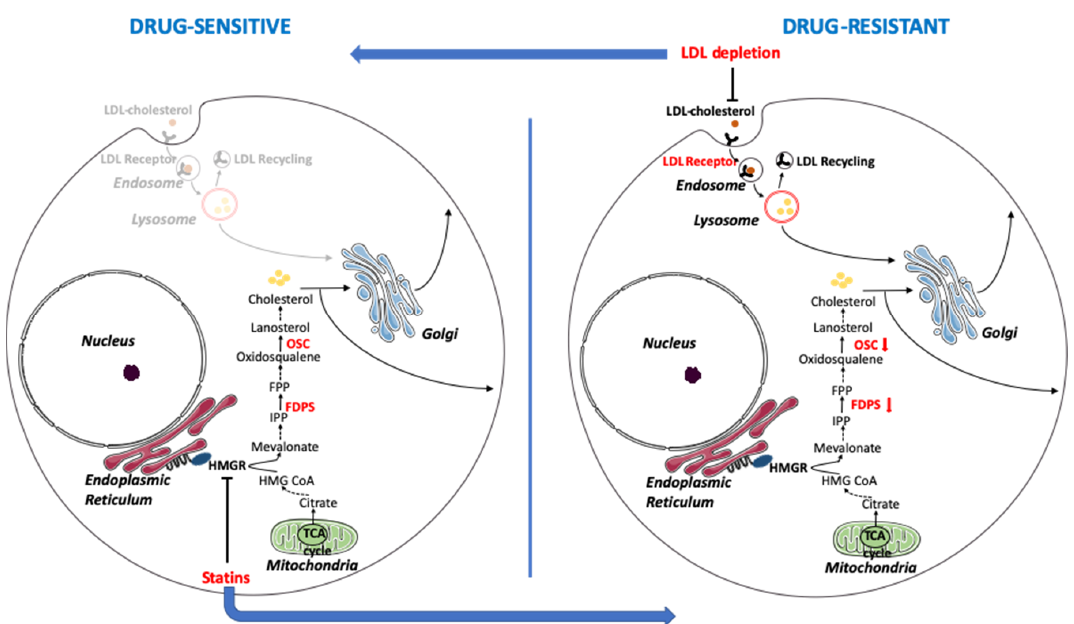
Figure 7. A proposed model for the remodeling of cholesterol metabolism in the transition from a chemosensitive to a chemoresistant phenotype in human ovarian cancer cells. Drug-sensitive cells show significant activation of the cholesterol biosynthetic pathway and transport of cholesterol through the Golgi apparatus, while uptake of exogenous cholesterol through the LDLR is limited. Drug resistant cells, on the opposite, show reduced levels of FDPS and OSC along the biosynthetic pathway and increased LDL uptake. The inhibition of 3-hydroxy-3-methylglutaryl-coenzyme A reductase (HMGCR), the rate-limiting enzyme of the biosynthetic pathway, by statins induces drug resistance, whereas the reduction of LDL recycling and lipid absorption through extracellular lipid withdrawal or LIPG knockdown sensitizes cells to drug-induced apoptosis. Enzymes whose expression has been analyzed in this work are in bold red. IPP = isopentenyl pyrophosphate; FPP = farnesyl pyrophosphate; TCA = tricarboxylic acid. This image was created using images from Servier